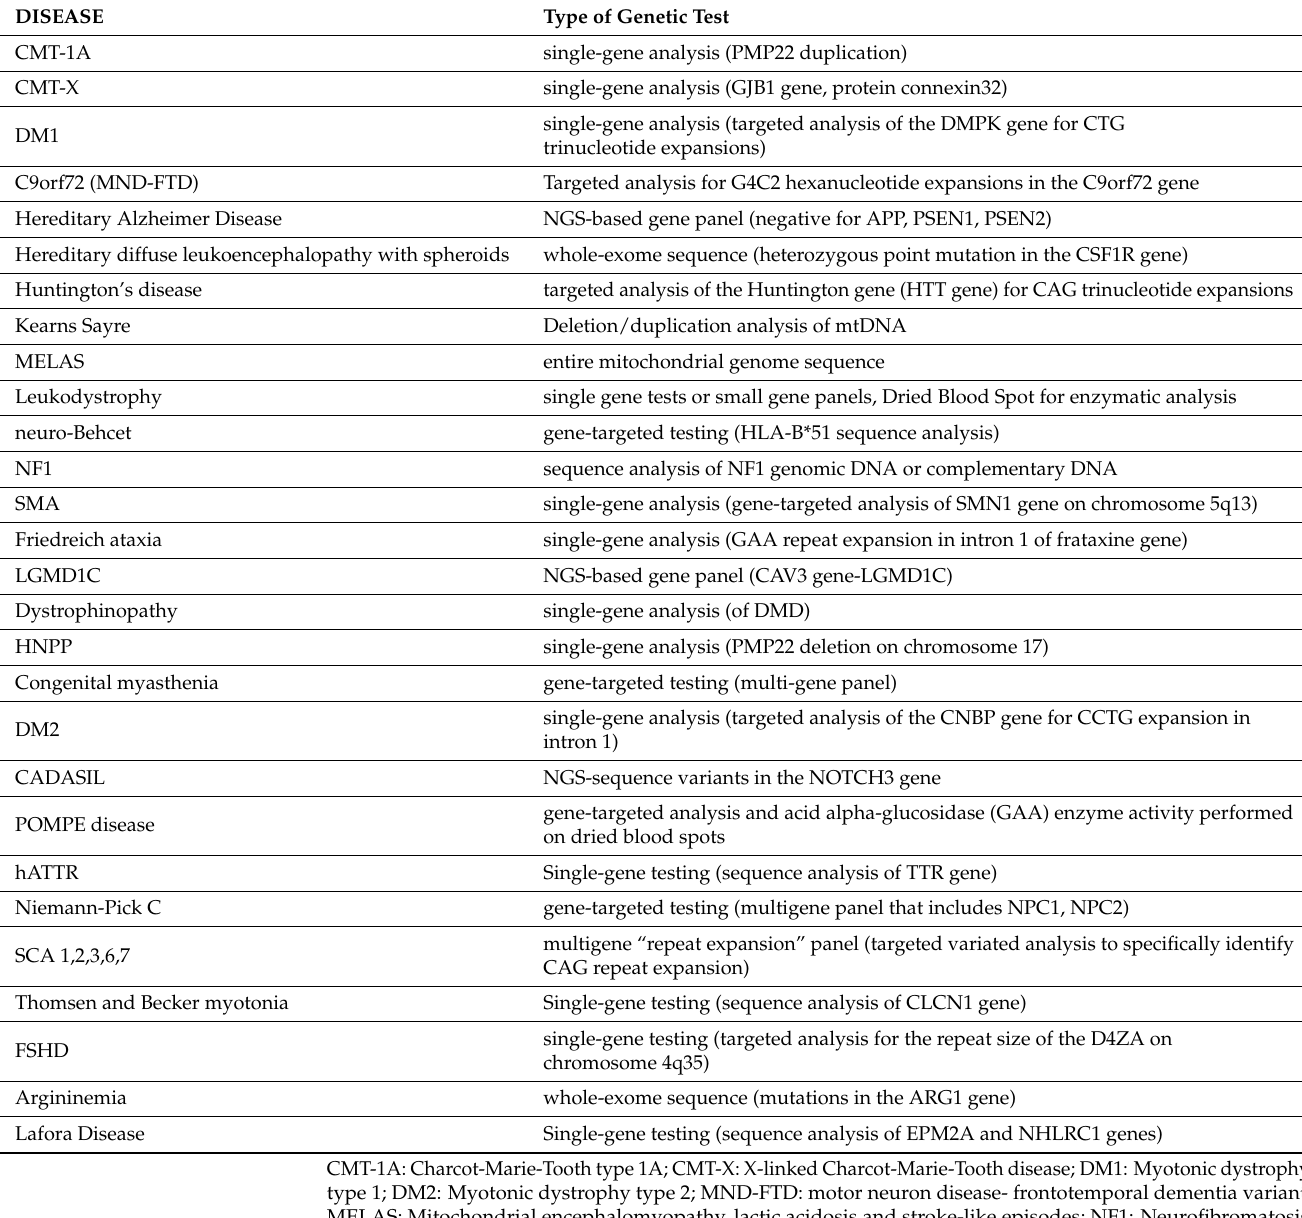
Table 3. Type of genetic testing performed to reach the diagnosis with